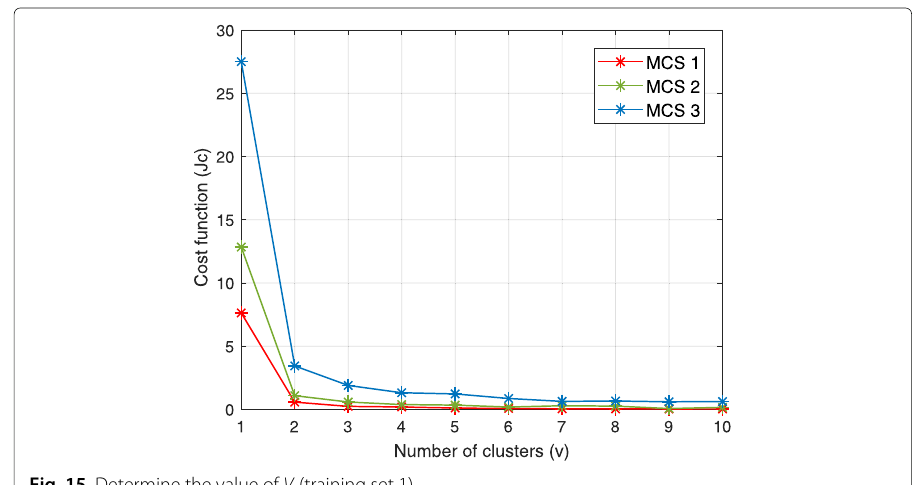
Fig. 15 Determine the value of V (training set 1)